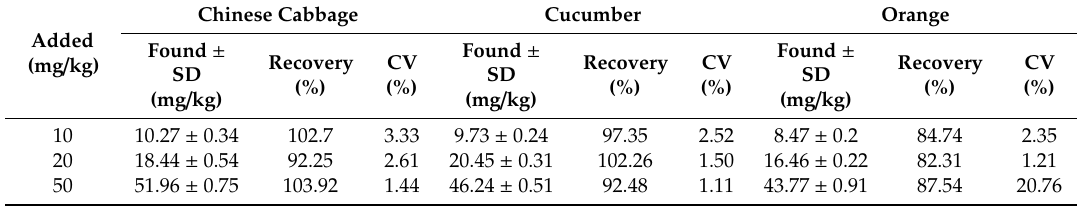
Figure 6. Matrix effects of Chinese cabbage, cucumber, and orange samples. Table 2. Recovery analysis of carbofuran in Chinese cabbage, cucumber, and orange samples by ic-ELISA.